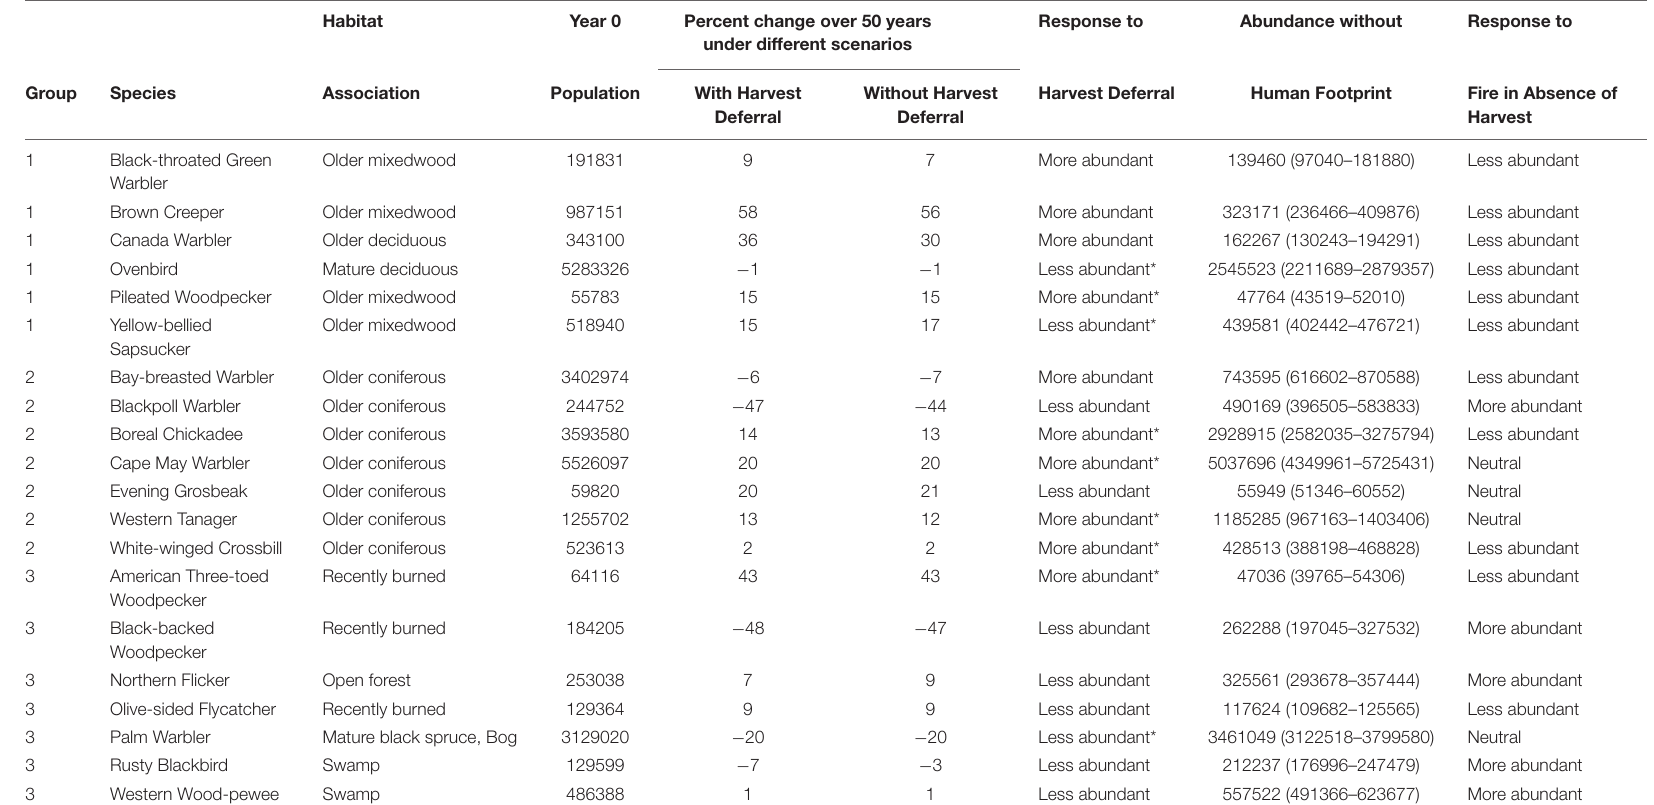
TABLE 2 | Initial population size and projected percent change in population of 20 species in the Al-Pac FMA over 50 years, along with projected response of each species, under two scenarios: (1) the Preferred Forest Management Scenario (PFM) that included harvest deferral within caribou habitats; and (2) the Ecosystem-Based Management/Natural Disturbance Model Scenario (EBM) without harvest deferral, relative to the predicted Natural Range of Variation (NRV) in abundance of each species in the absence of human